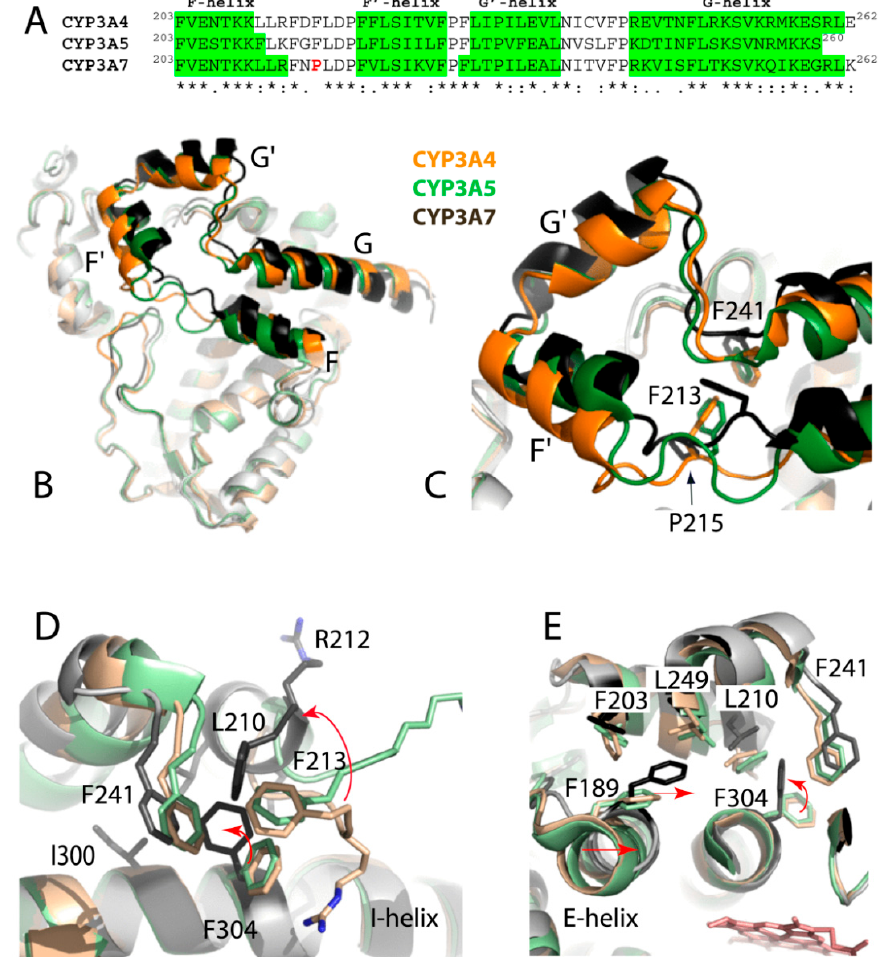
Figure 5. ( A ) Sequence alignment of the F-G fragments in CYP3A enzymes. ( B ) Superposition of CYP3A4 (5vcc; orange), CYP3A5 (6mjm; green), and CYP3A7 (molecule A; gray/black). ( C ) Magni- fied view of the distinctly folded F-F ′ -G ′ -G segments. ( D ) F304-centered cluster formation in CYP3A7 (depicted in gray/black). Arrows show rotameric change in F304 from “inward” in CYP3A4/5 to “upward” in CYP3A7, where a subsequent conformational switch in the 210–213 frag- ment promotes clustering of L210, L211, F213, and F241. ( E ) Side view showing that rotameric switch in F304 triggers movement of F189 and the E-helix (indicated by arrows).